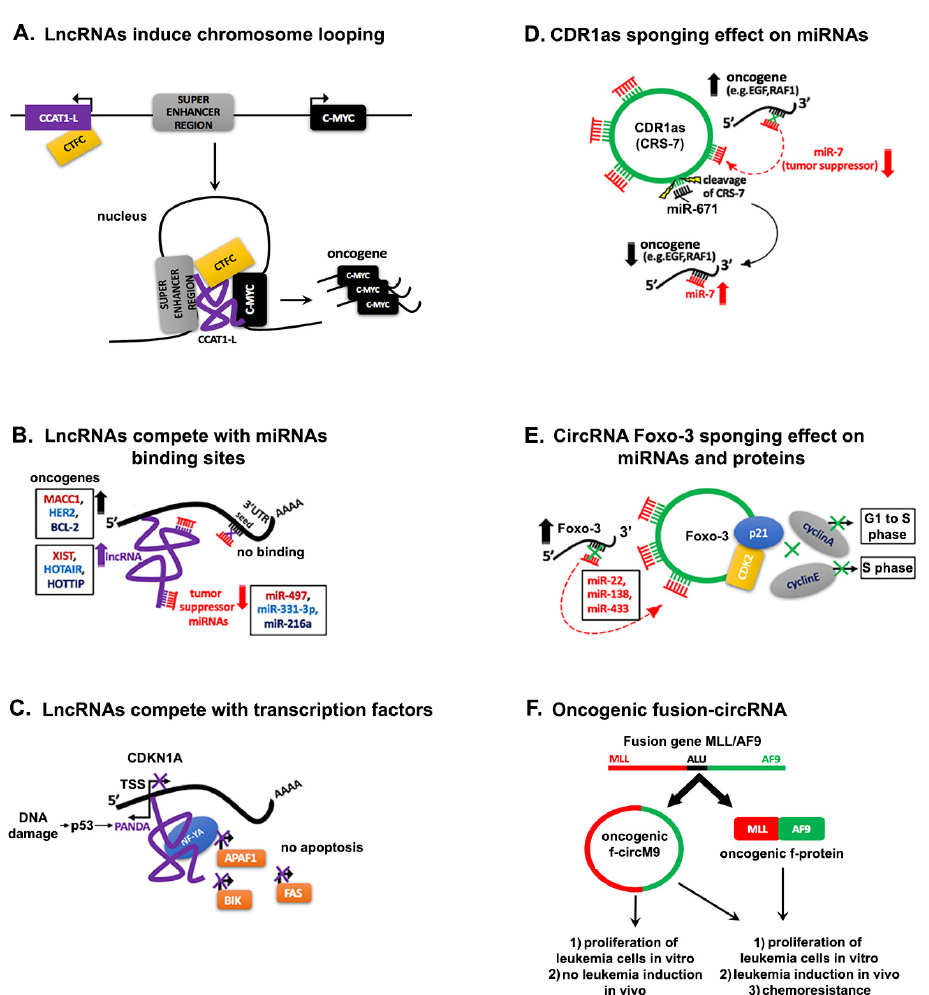
Figure 2. Interactions of ncRNAs in cancer. ( A ): LncRNA, CCAT1 ‐ L, interacts with the chromatin binding factor, CTCF. CCAT1 ‐ L is transcribed upstream of the oncogene MYC enhancer region, promotes chromosome looping that brings into proximity the super enhancer to the MYC promoter and induces enhanced transcription of MYC in colorectal cancer. ( B ): LncRNAs (XIST, HOTAIR, HOTTIP) compete with the binding of miRNA target genes. Each color corresponds to a lncRNA ‐ oncogene ‐ miRNA interaction. Tumor suppressor miRNAs cannot bind to their target oncogenes because they are sequestered by lncRNAs. ( C ): PANDA antisense transcription is induced by p53, counteracts CDKN1 inhibitory effect on the cell cycle and decoys the transcription factor NF ‐ YA. The latter cannot bind anymore to the promoter of apoptotic activators such as APAF1, BIK, FAS. (TSS: transcriptional start site). ( D ): CDR1 decoys the tumor suppressor miR ‐ 7, which cannot bind to its oncogene targets. miR ‐ 671 cleaves CDR1 and alleviates miR ‐ 7 decoying. The latter is now able to suppress its targets. ( E ): Circ ‐ Foxo3 forms a ternary complex with two cell cycle regulatory proteins, p21 and CDK2 to block the cell cycle progression. Foxo3 and circ ‐ Foxo3 in a breast cancer cell line decreased cell proliferation and induced extensive cell death due to apoptosis in tumors formed by the same cell line in nude mice. ( F ): Chromosomal translocations of the oncogenes MLL/AF9 in AML produce the fusion of the due oncogenes to form fusion (f) ‐ circM9 and a fusion protein. Both, f ‐ circM9 together with the f ‐ protein induced leukemia in vivo and resistance to chemotherapy.